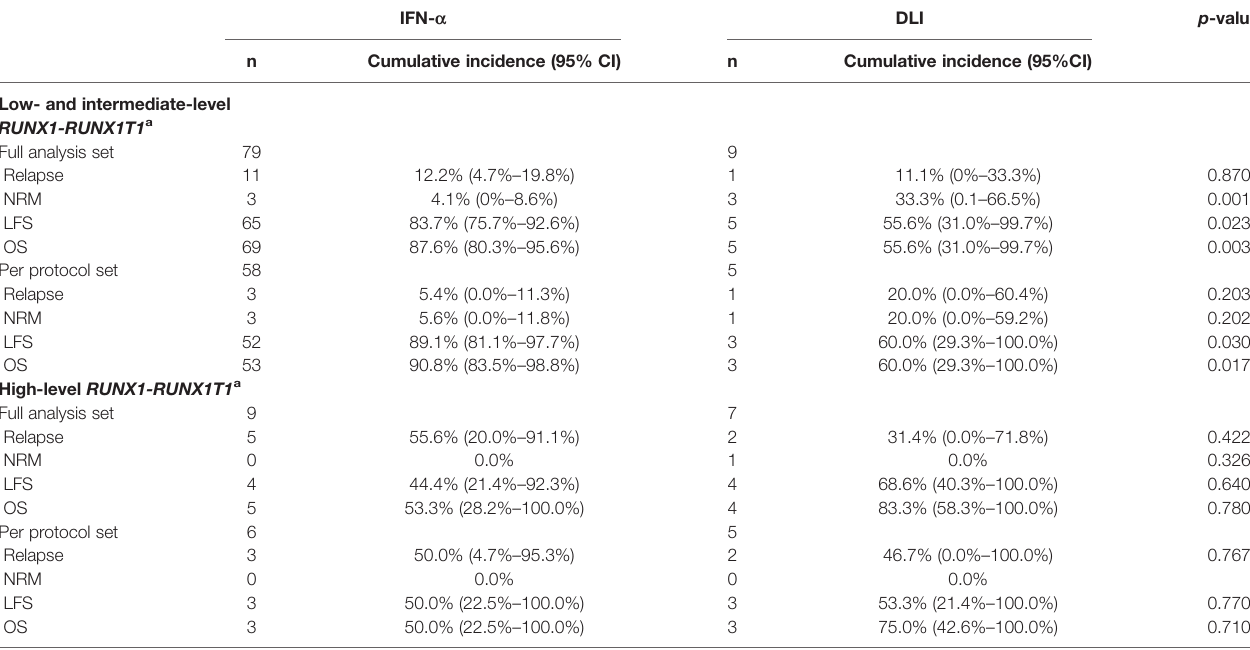
TABLE 2 | The 2-year cumulative incidence of relapse, NRM, LFS, and OS after preemptive